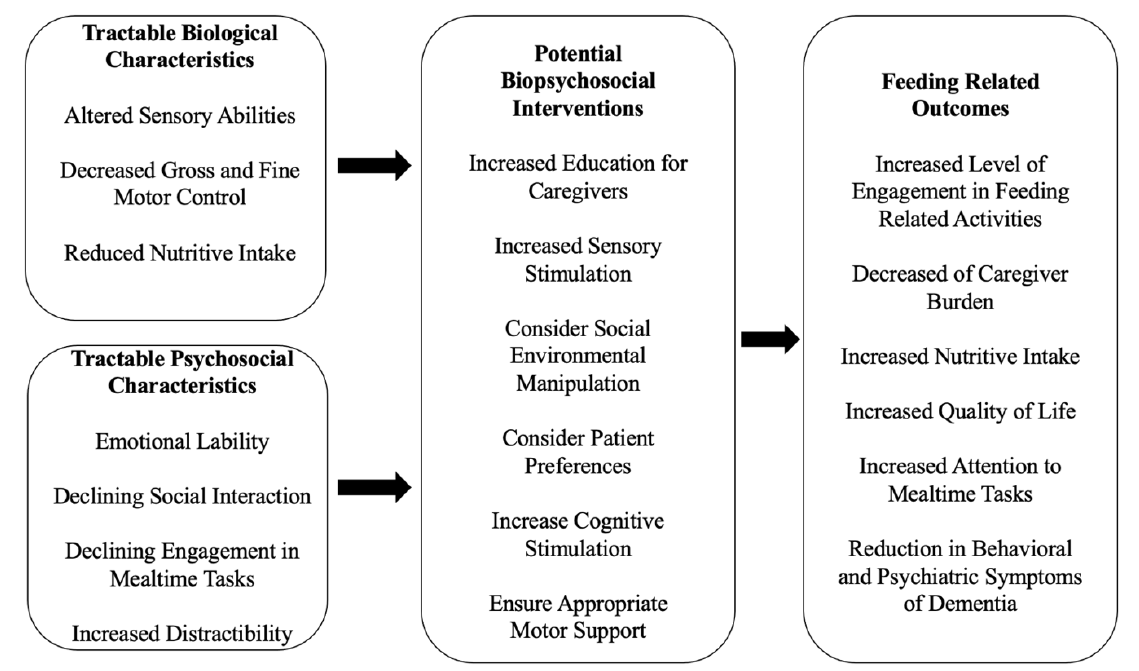
Figure 2. Dysphagia management in PWD utilizing a biopsychosocial model as an asset-based approach to patient-centered care.